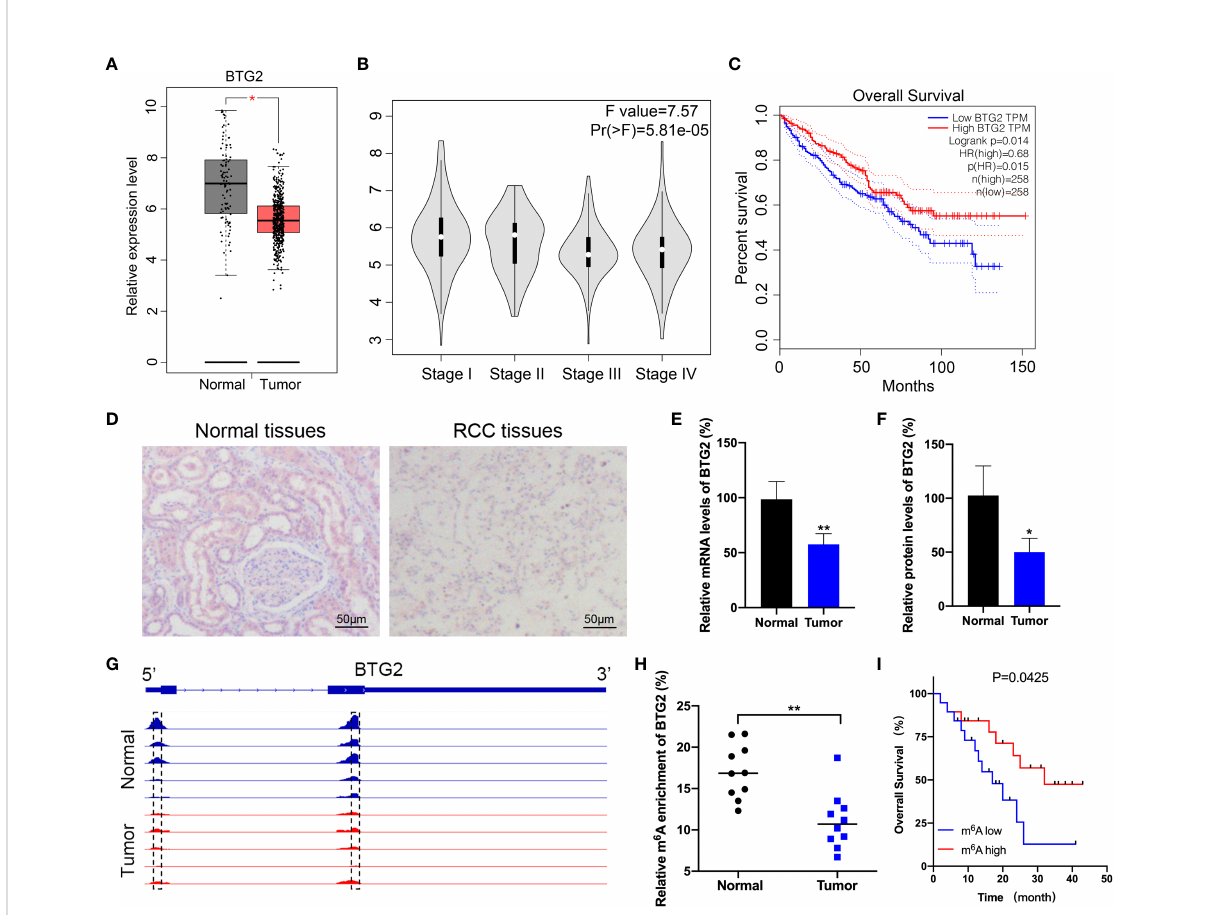
FIGURE 1 BTG2 expression and m 6 A methylation level in RCC patients. (A) An analysis of BTG2 mRNA expression in RCC tumor tissues (red plot) and normal tissues (grey plot) is shown in the box plot below based on TCGA database. (B) The expression levels of BTG2 in different stages of RCC based on TCGA database. (C) The survival plot for RCC patients strati fi ed by expression of BTG2. (D) The protein expression levels of BTG2 in tumor tissues and normal tissues analyzed by IHC. (E) The mRNA expression levels of BTG2 in tumor tissues and normal tissues analyzed by RT-qPCR. (F) The protein expression levels of BTG2 in tumor tissues and normal tissues analyzed by western blot. (G) The m 6 A peaks within BTG2 mRNA in tumor tissues and normal tissues analyzed by IGV. (H) The m 6 A enrichment of BTG2 in tumor tissues and normal tissues analyzed by MeRIP-qPCR. (I) The survival plot for RCC patients strati fi ed by m 6 A level of BTG2. * P<0.05, **